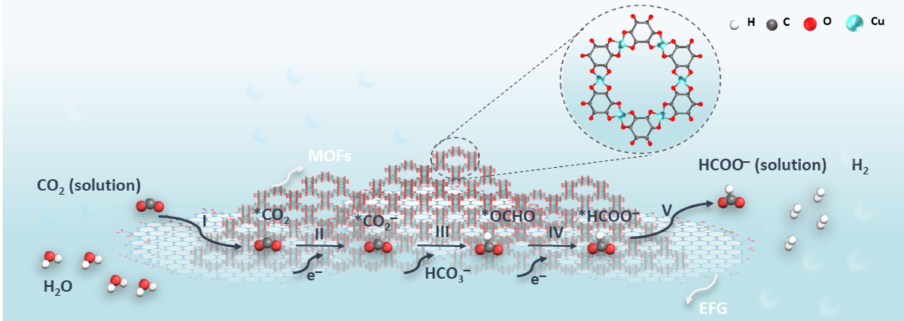
Scheme 2. Illustration of the proposed electrocatalytic process of converting CO 2 into